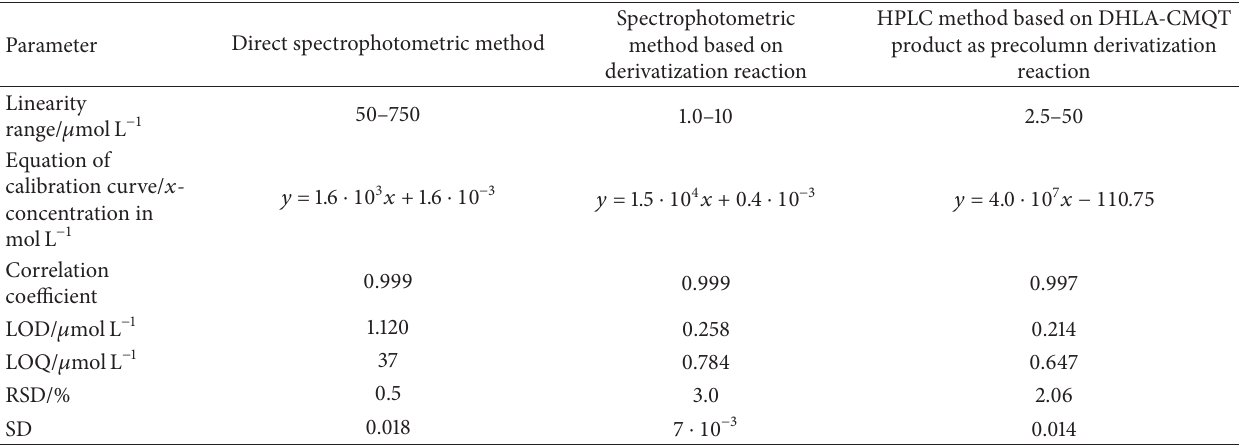
Table 2: Validation parameters of elaborated methods.